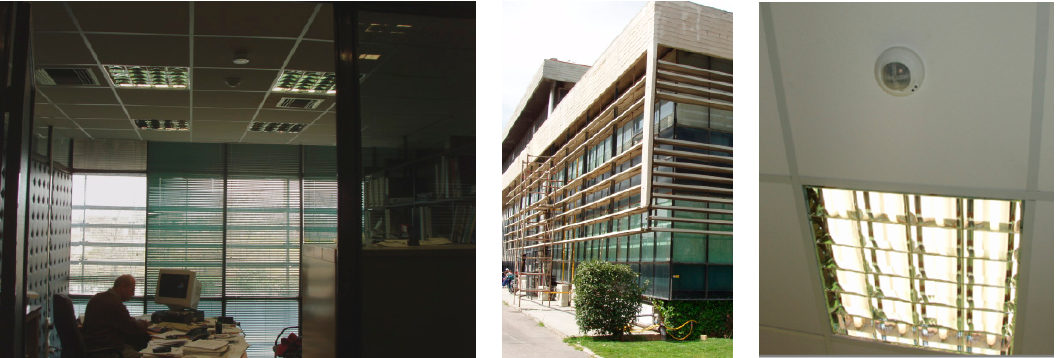
Figure 2. Interior space ( left ), exterior façade ( middle ) and position of the photosensor ( right ) for Building A.